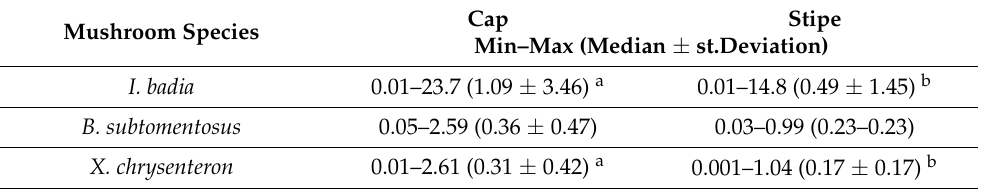
Table 2. Content of Hg (mg kg − 1 ) in caps and stipes of three edible mushroom species expressed by descriptive statistics and the results of the Kruskal-Wallis test expressing significant differences in Hg content between species ( a , p < 0.001; b , p <